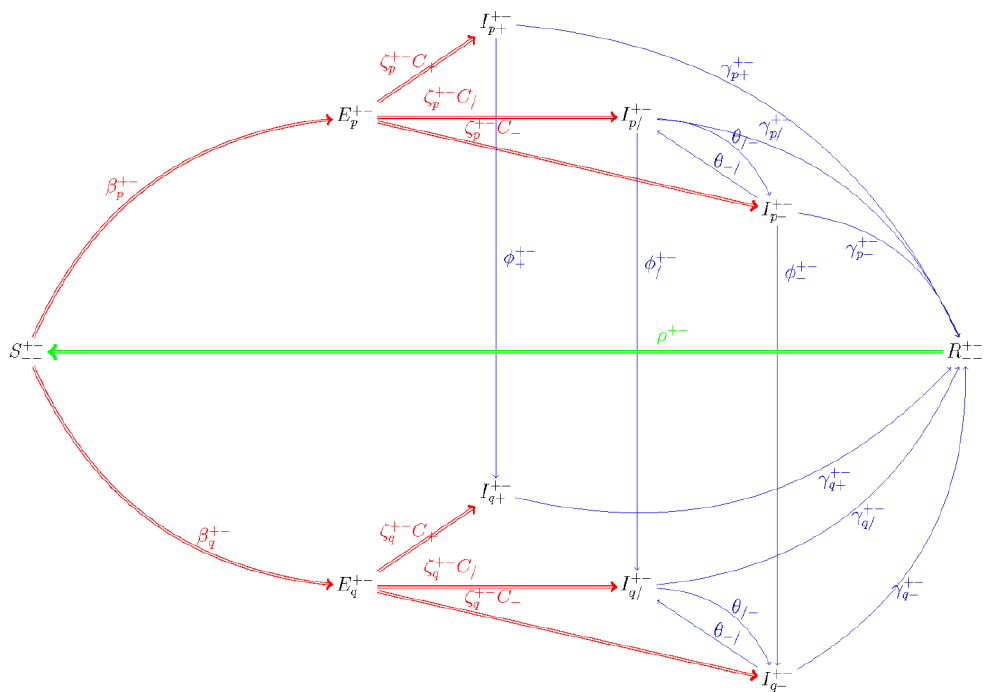
Figure 5. Compartmental Susceptible-Exposed-Infectious-Recovered (SEIR) Model: The model follows the progression of fully immunocompetent, HIV/AIDS+, HAART- and HIV+/HAART+ susceptibles who become infected with either drug-sensitive (p) or drug-resistant (q) TB strains. As an example, we include a diagram depicting this process for actively AIDS-immunocompromised ( 𝑆 −−+− ) susceptibles who have not previously received antibiotic prophylaxis.